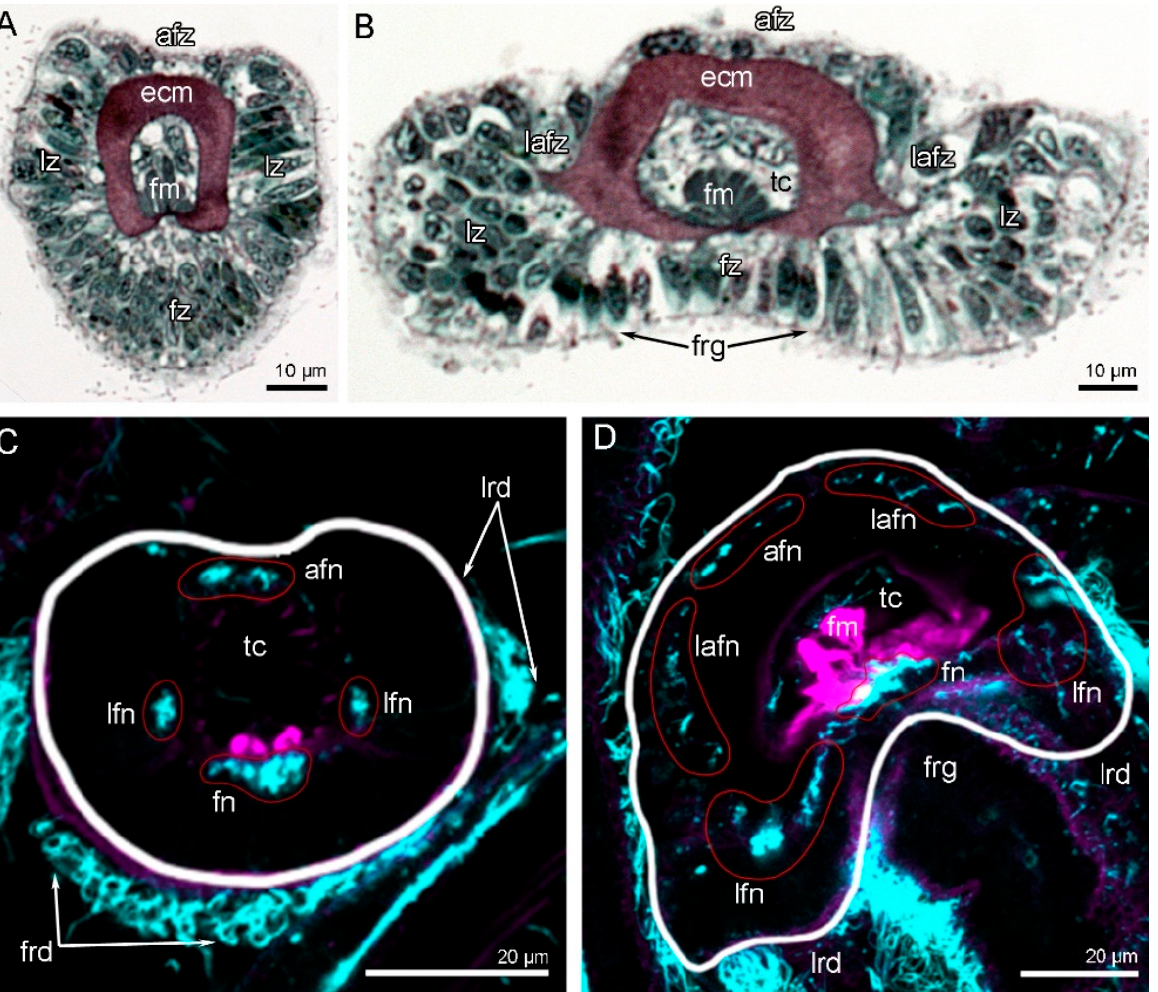
Figure 3. Tentacle organization and innervation in Novocrania anomala adults. Semi-thin cross-sections ( A , B ); Z-projections of two adjacent slides of the stack after immunostaining against acetylated alpha-tubulin (cyan) and staining with phalloidin (magenta) ( C – D ). White line shows the edge of the tentacles; red circles indicate certain tentacle nerves, which consist of several neurite bundles. ( A ) Inner tentacle. ( B ) Outer tentacle. ( C ) Z-projection of cross-section of the inner tentacle. ( D ) Z-projection of cross-section of the outer tentacle. Abbreviations: afn—abfrontal tentacle nerve; afz—abfrontal zone; ecm—extracellular matrix; fm—frontal muscle; fn—frontal tentacle nerve; frd—frontal ciliated ridge; frg—frontal groove; fz—frontal zone; lafn—lateroabfrontal tentacle nerve; lafz—lateroabfrontal zone; lfn –laterofrontal tentacle nerve; lrd—lateral ciliated ridge; lz—lateral zone; tc—tentacle coelom.